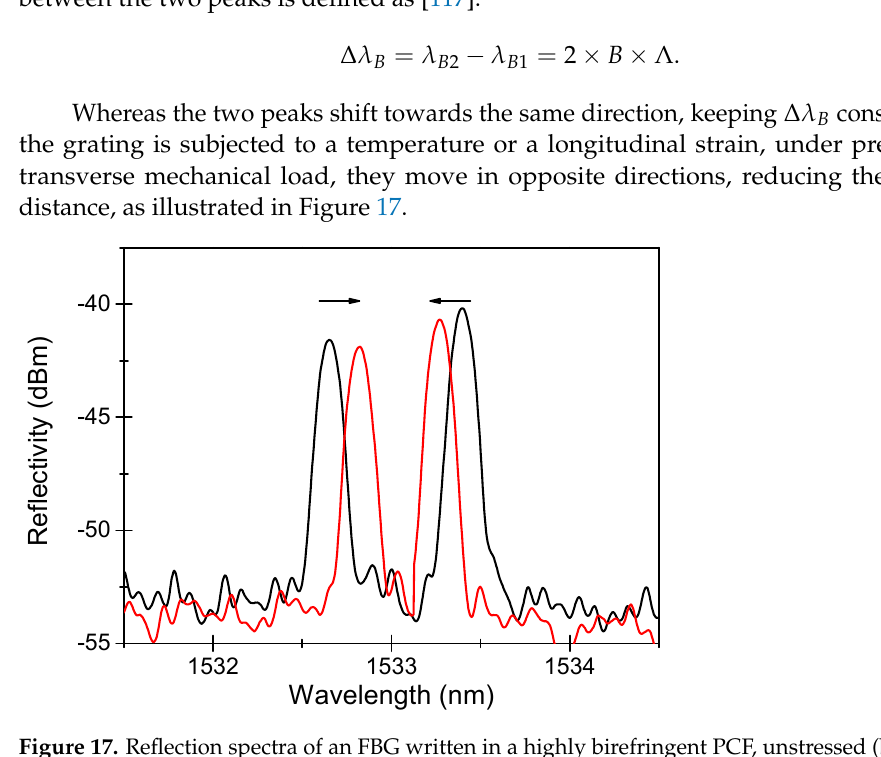
Figure 17. Reflection spectra of an FBG written in a highly birefringent PCF, unstressed (black curve), and when a transverse load is applied (red curve). The arrows highlight the direction of the shift in the peaks.